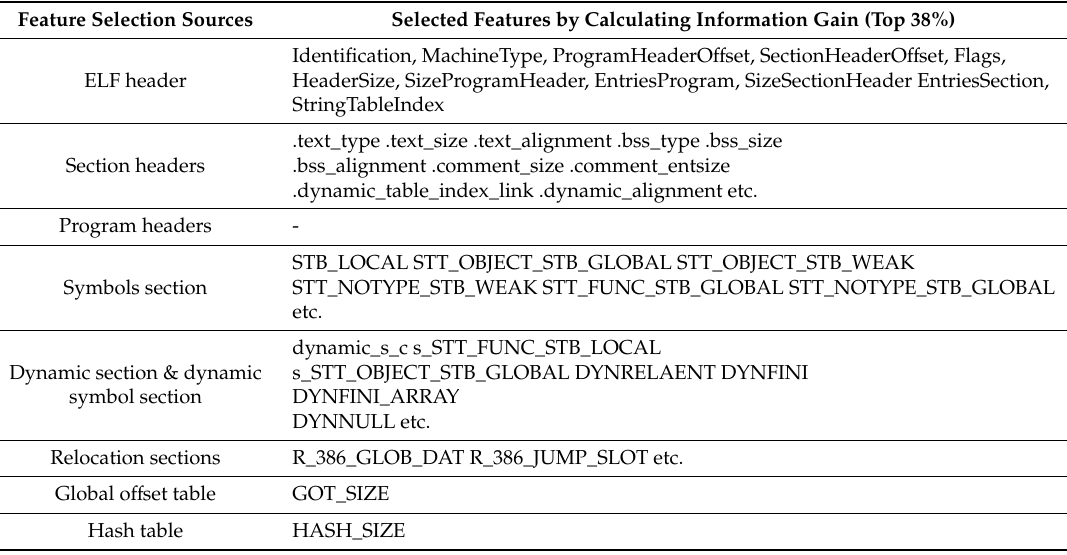
Table 7. Selected ELF features after calculating information